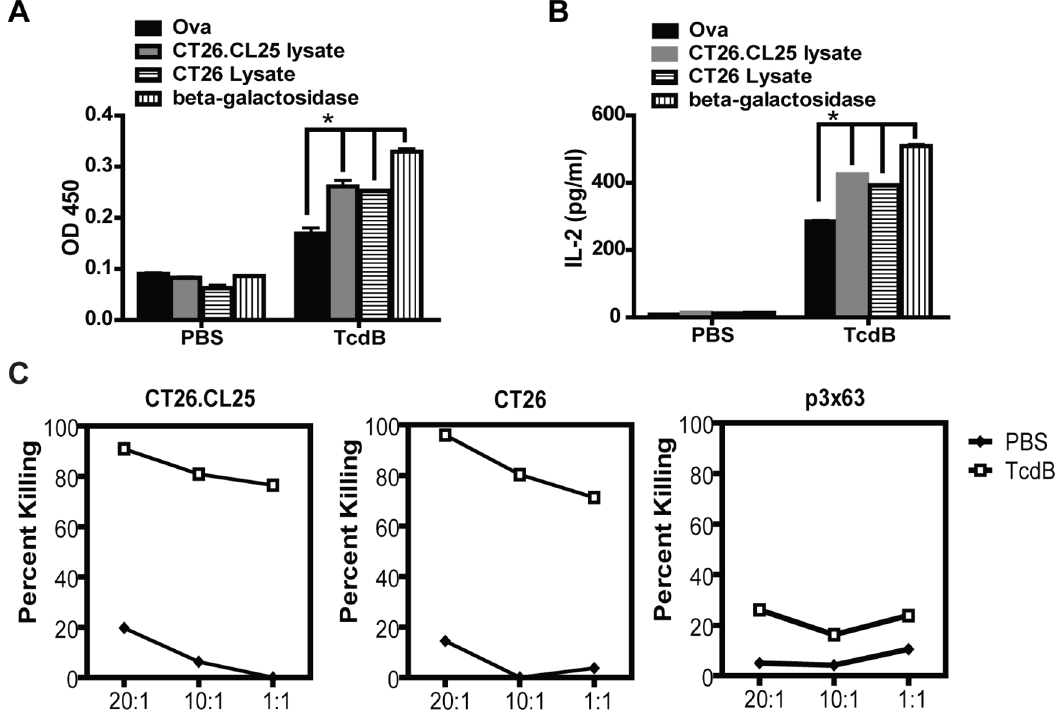
Figure 4. T-cell proliferation, IL-2 secretion, and specific CTL activity of splenocytes from immunized mice. Mice were immunized twice with PBS or TcdB-intoxicated CT26.CL25 (TcdB), and splenocytes were harvested 5 days after the second immunization. (A and B) splenocytes were restimulated with OVA, CT26.CL25 lysate, CT26 lysate, and b -galactosidase. (A) T-cell proliferation was determined by BrdU cell proliferation assay. (B) IL-2 production was measured by ELISA. The data in (A) and (B) represent the mean of three independent experiments 6 SEM. *represents P , 0.05 (one-way ANOVA). (C) Specific CTL induction. Splenocytes restimulated with CT26.CL25 lysate were tested for cytolytic activity against CT26.CL25 cells, parental CT26 cells, or myeloma p3x63Ag8.653 cells using cytotoxicity detection kit (LDH) assay. Representative data from one of three independent experiments are shown.